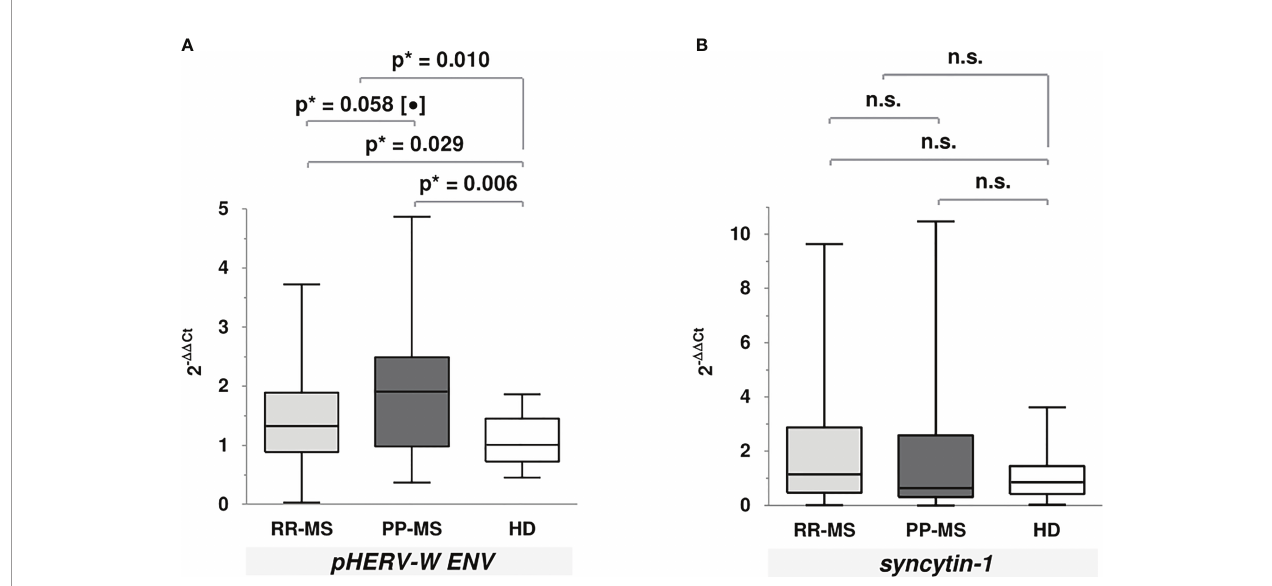
FIGURE 2 | Gene expression levels of pHERV-W ENV and syncytin-1 using the 2 - DD Ct method. (A) pHERV-W ENV [median (P25-P75)]: RR-MS = 1.33 (0.89-1.89); PP-MS = 1.91 (0.98-2.49); HD = 1.01 (0.72-1.45). (B) Syncytin-1 [median (P25-P75)]: RR-MS = 1.15 (0.47-2.88); PP-MS = 0.64 (0.31-2.59); HD =0.86 (0.42-1.45). [*Mann-Whitney U test; ( (cid:129) ) tendency to signi fi cation; n.s., not signi fi